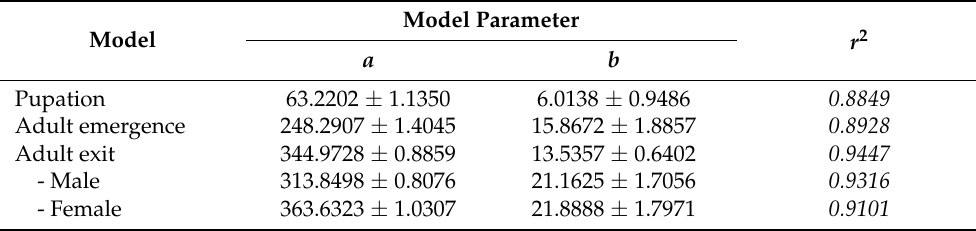
Figure 2. The 2-parameter Weibull distribution model for the cumulative proportion of development stages of Eurytoma maslovskii after diapause break by degree day. Table 4. The two-parameter Weibull function for the cumulative distribution of Eurytoma maslovskii after diapause break based on accumulated degree days.